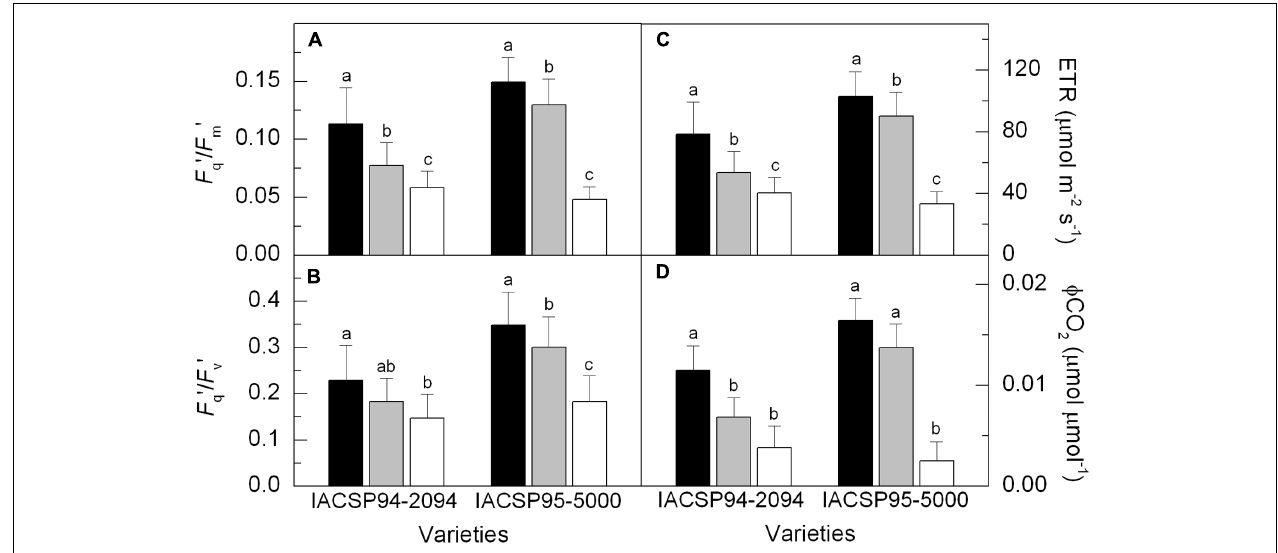
FIGURE 3 | Operating efficiency of photosystem II ( F q (cid:48) / F m (cid:48) , in A ), photochemical quenching ( F q (cid:48) / F v (cid:48) , in B ), apparent electron transport rate (ETR , in C ) and CO 2 fixation efficiency ( φ CO